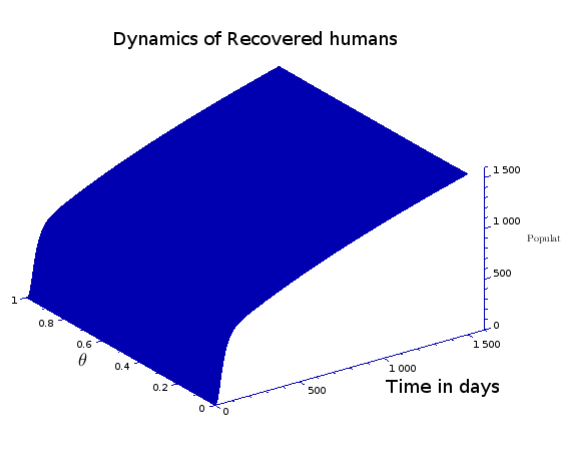
Fig. 4: The number of recovered individuals ( e = 1000 , g ( t , θ ) = 59 ∗ 365